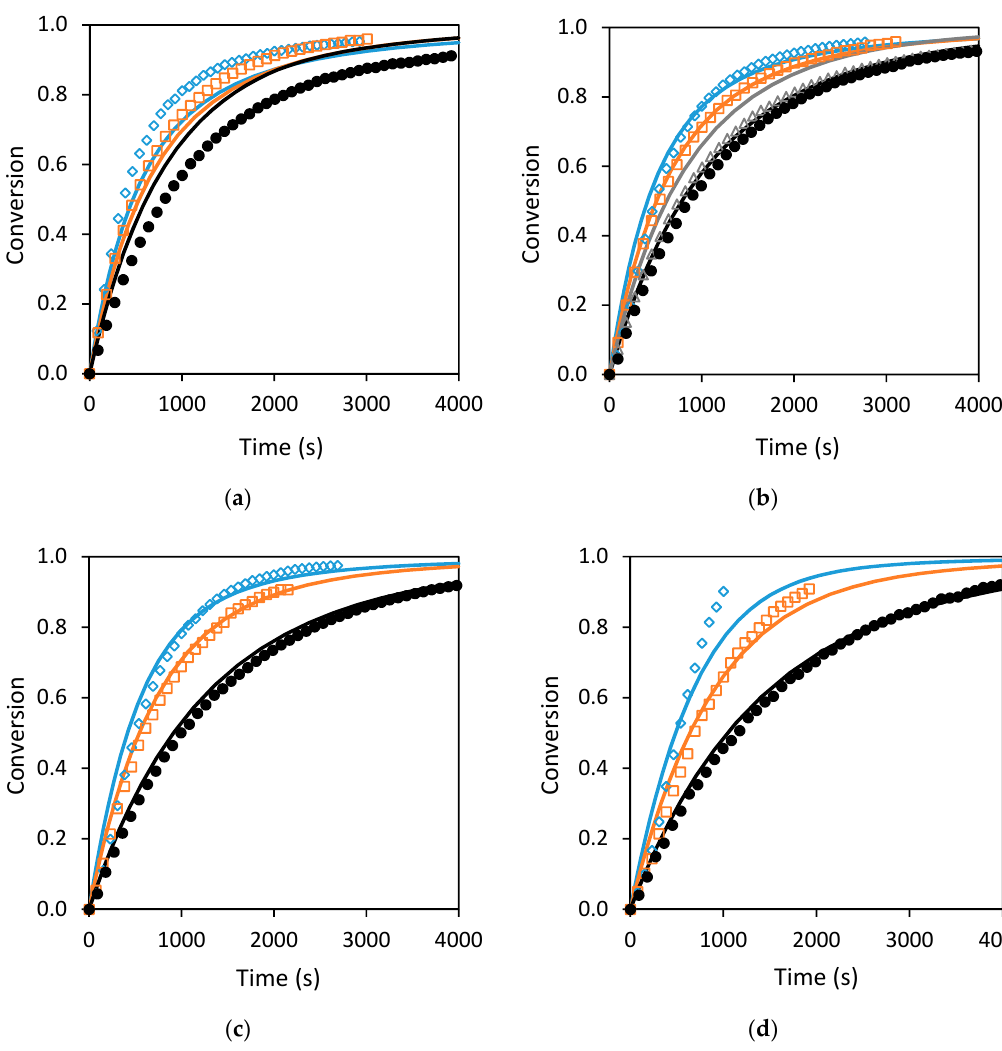
Figure 10. Simulated conversion profiles (lines) compared to experimental results (points) for f MAPTAC,0 = 0.3( ◊ ), 0.5( ), 0.7( Δ ) and 0.9( ● ) at 50 °C and 0.80 wt% V-50 with w mon,0 of ( a ) 0.05, ( b ) 0.10, ( c ) 0.20 and ( d ) 0.40. Profiles are calculated using the model summarized in Tables 1 and 2, with the copolymer termination rate coefficient calculated using the geometric mean method (best fit Φ values = 2.9).